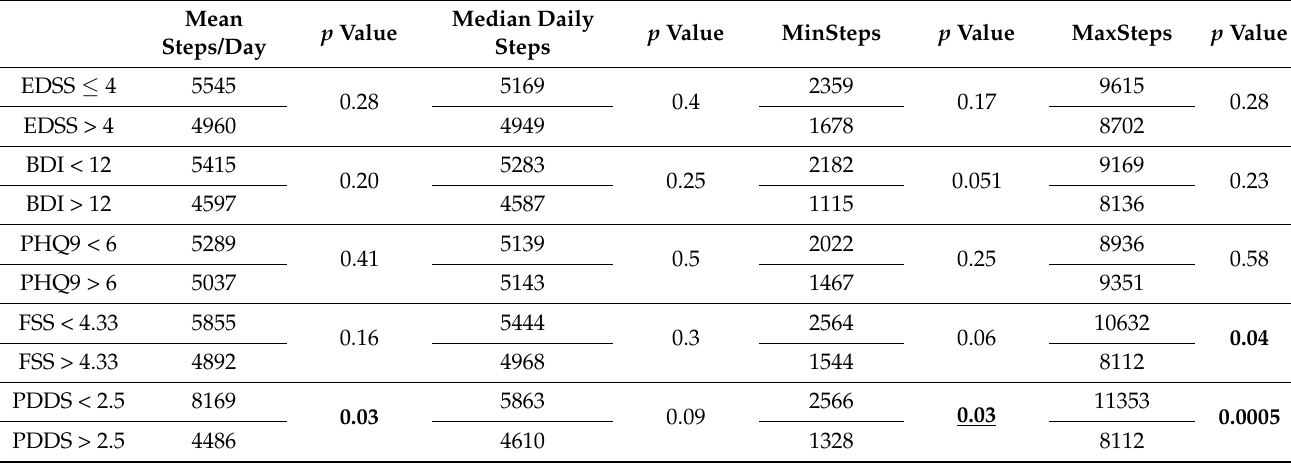
Table 2. Difference in the means of the motor parameters detected with the accelerometer in PwMS, divided into two categories for each test or clinical scale according to the defined cut-offs.